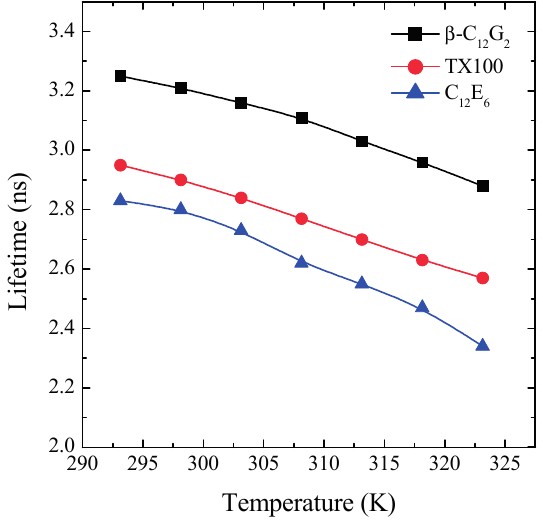
Figure 5. Effect of temperature and the nature of the micellar system on the lifetime values of C6 solubilized in the micellar media ( λ exc = 405 nm and λ em = 505